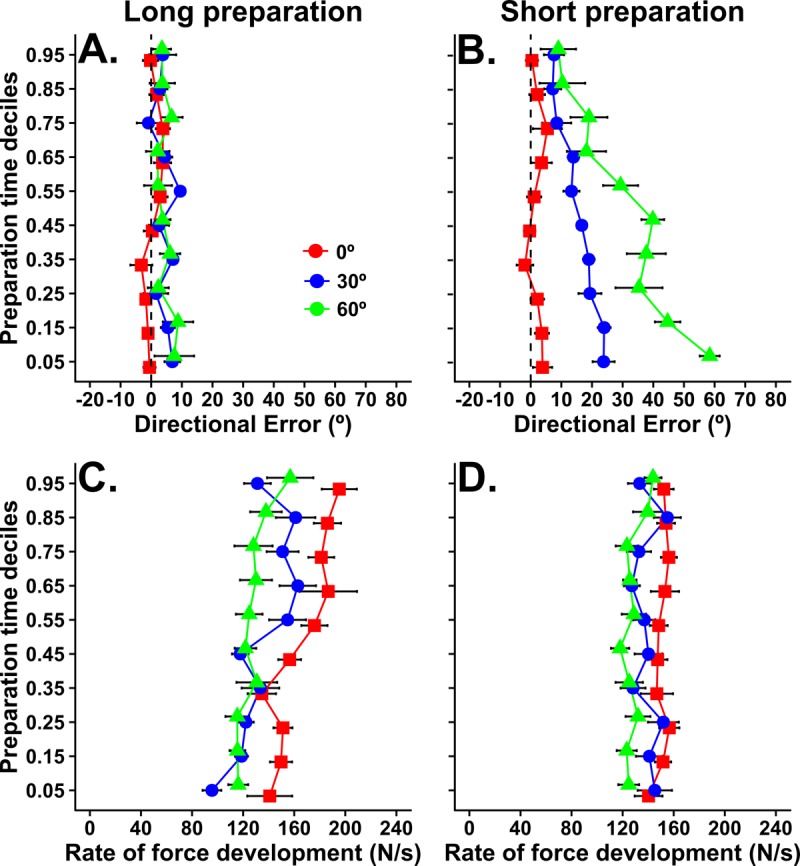
Plots showing how movement bias (top) and vigor (bottom) vary as a function of preparation time and target angle within each preparation time condition in experiment 1.Group average (and within-subjects SE) values for bias and vigor are plotted for trials corresponding to each preparation time decile. That is, a value at the fifth percentile for preparation time is the bias or vigor measured on the trial in which the available preparation time was at the fifth percentile (i.e. fifth shortest preparation time assuming 100 trials).10.7554/eLife.26713.006Figure 3—source data 1.Source data for plots in panels 3a, 3b, 3c, 3d.